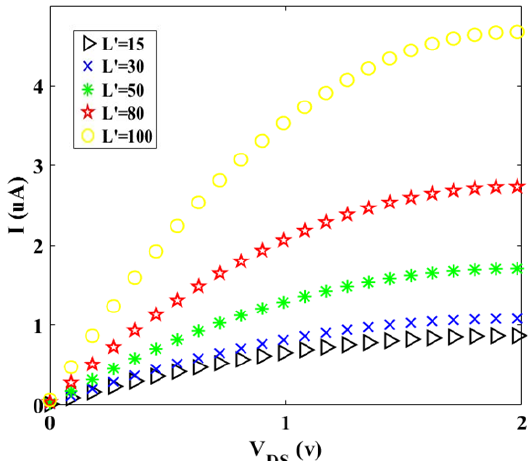
Figure 6. I-V characteristic for different values of channel length (in nm) at room temperature ( Z = 10 and S = 5). and S = 5).